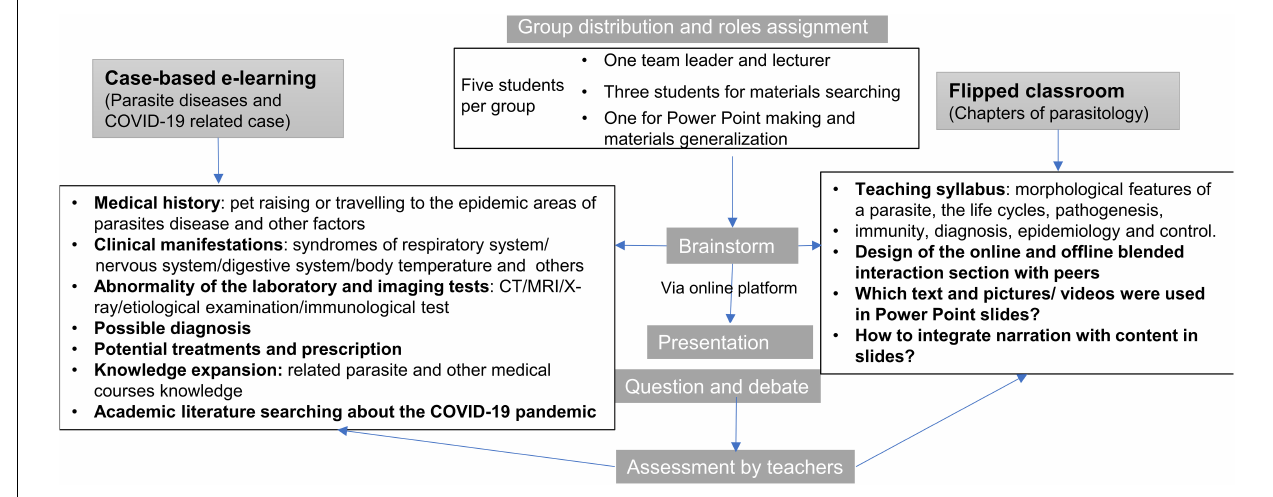
FIGURE 2 | Modified case-based e-learning (CBEL) and the flipped classroom (FC) in online–offline combined teaching during the normalization stage of